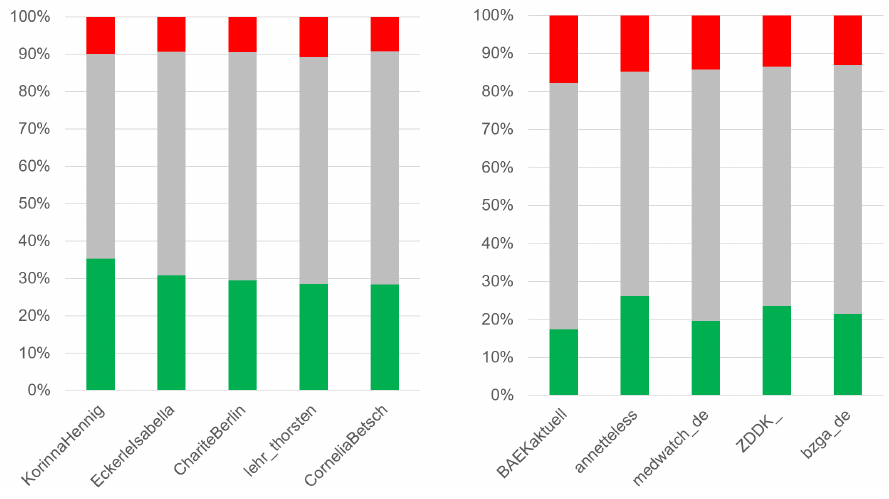
Figure 6. Sentiment analysis for science communication